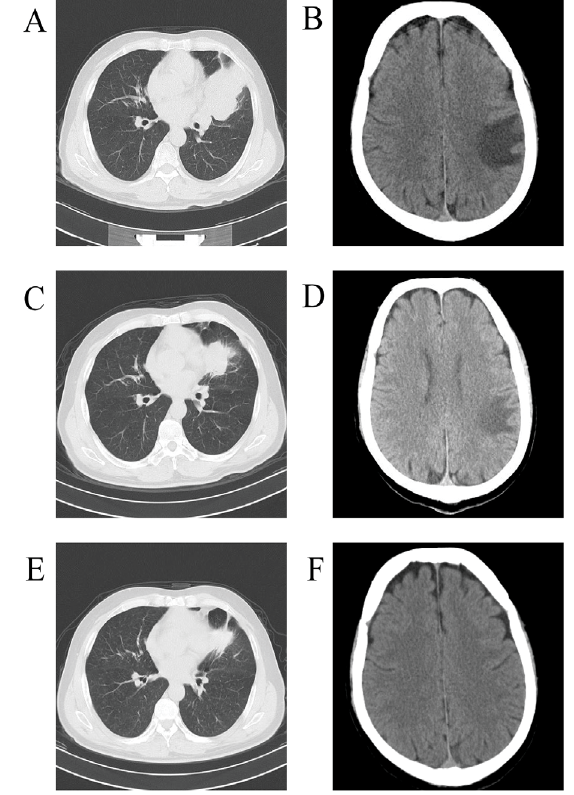
Figure 1: Computer tomography (CT) scans of lung lesion and brain metastasis before and after icotinib treatment. (A and B) At diagno- sis of the metastases (Oct 12, 2013); (C and D) After 16 days of icoti- nib therapy (Oct 28, 2013), revealing a good response to treatment; (E and F) After 47 days of icotinib treatment (Nov 26, 2013), revealing brain lesion completed